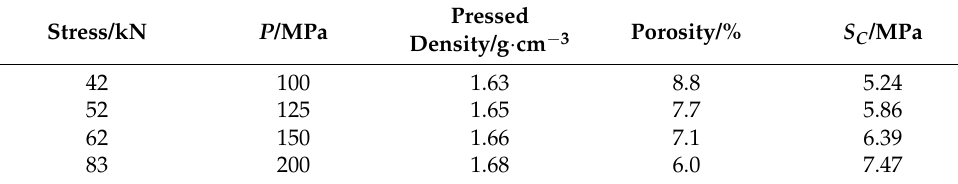
Table 6. Compressive strength of PBX with different pressing